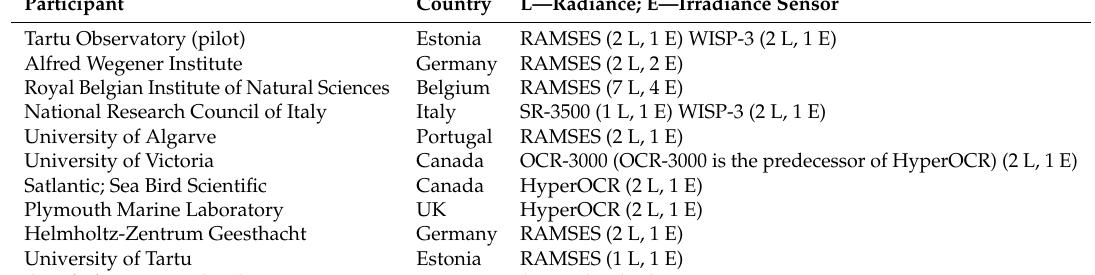
Table 1. Institutes and instruments participating in the LCE-2 intercomparison.